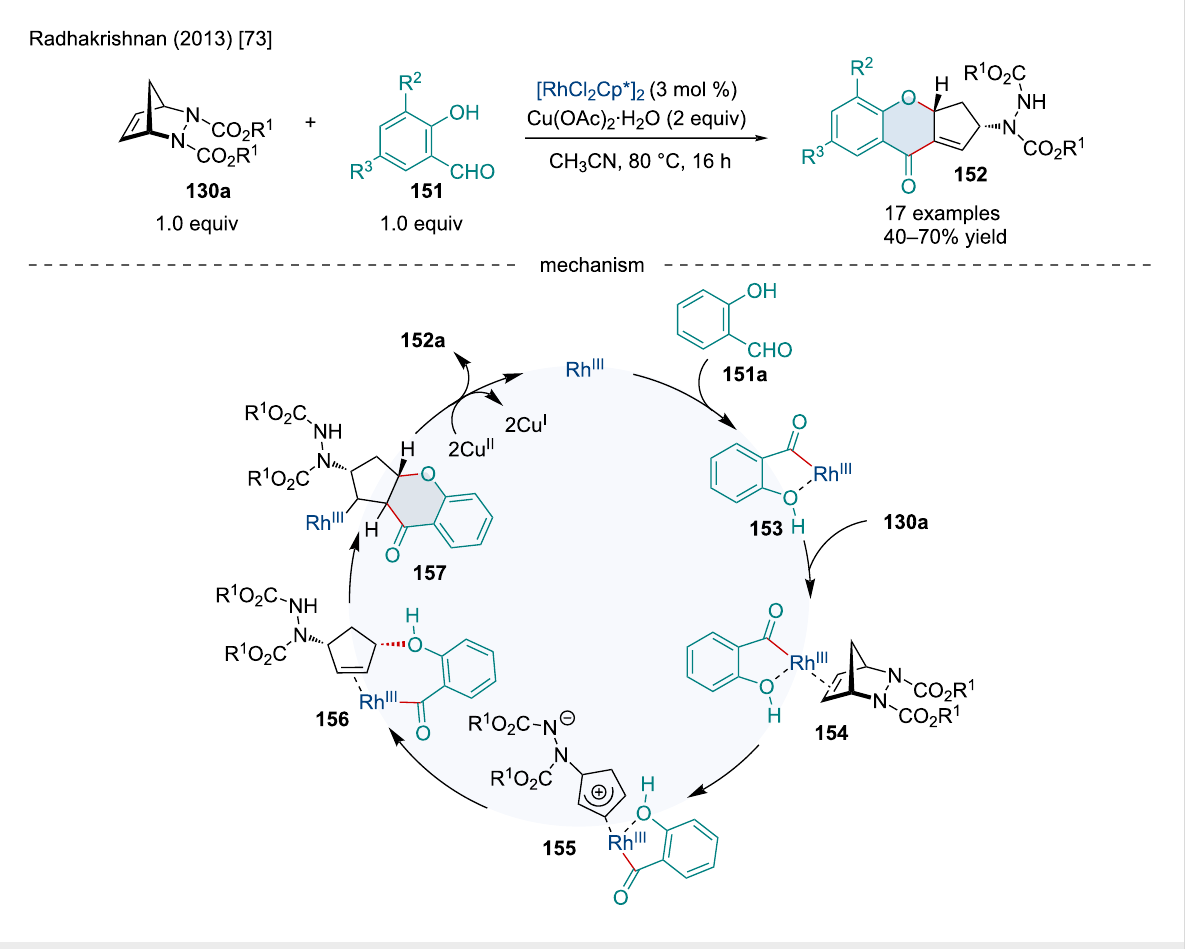
Scheme 27: Rh-catalyzed oxidative coupling of salicylaldehyde derivatives 151 with diazabicyclic alkenes 130a .